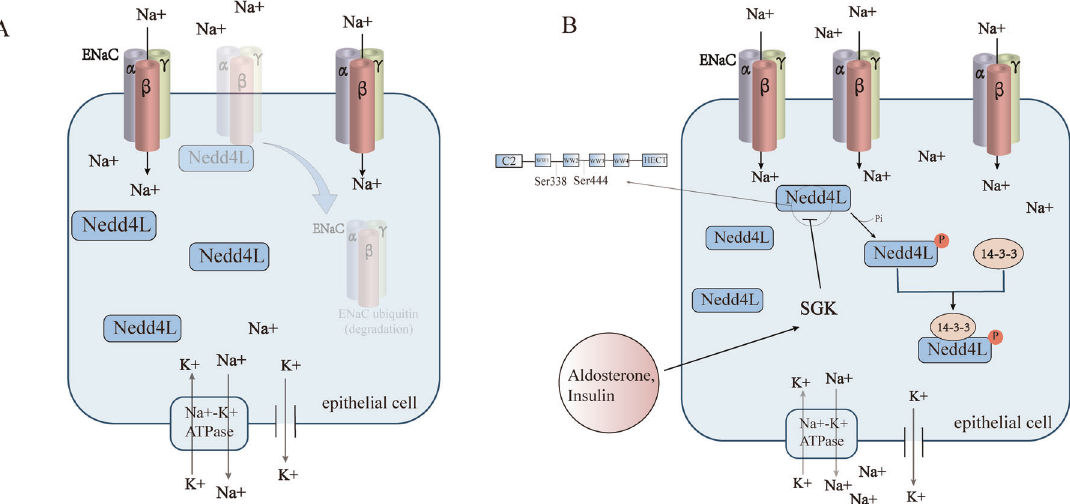
Fig. 1 The mechanism diagrams of how SGK1 regulates sodium reabsorption by Nedd4L. A Epithelial sodium channel (ENaC) can be degraded by Neuronal precursor cell expression developmentally downregulated 4-like (Nedd4L) to maintain sodium balance. B Serum and glucocorticoid-regulated kinase 1(SGK1) phosphorylates and inhibits Nedd4L which is an ubiquitin ligase, thereby failing to reduce the channel expression and stimulate ion channel degradation. The phosphorylation (mainly surrounding amino acids Ser444, Ser338) mediated by SGK1 induces the interaction of Nedd4L with members of the 14-3-3 protein family, which in turn disrupts the ubiquitination and degradation of ENaC by Nedd4L, ultimately leading to more sodium